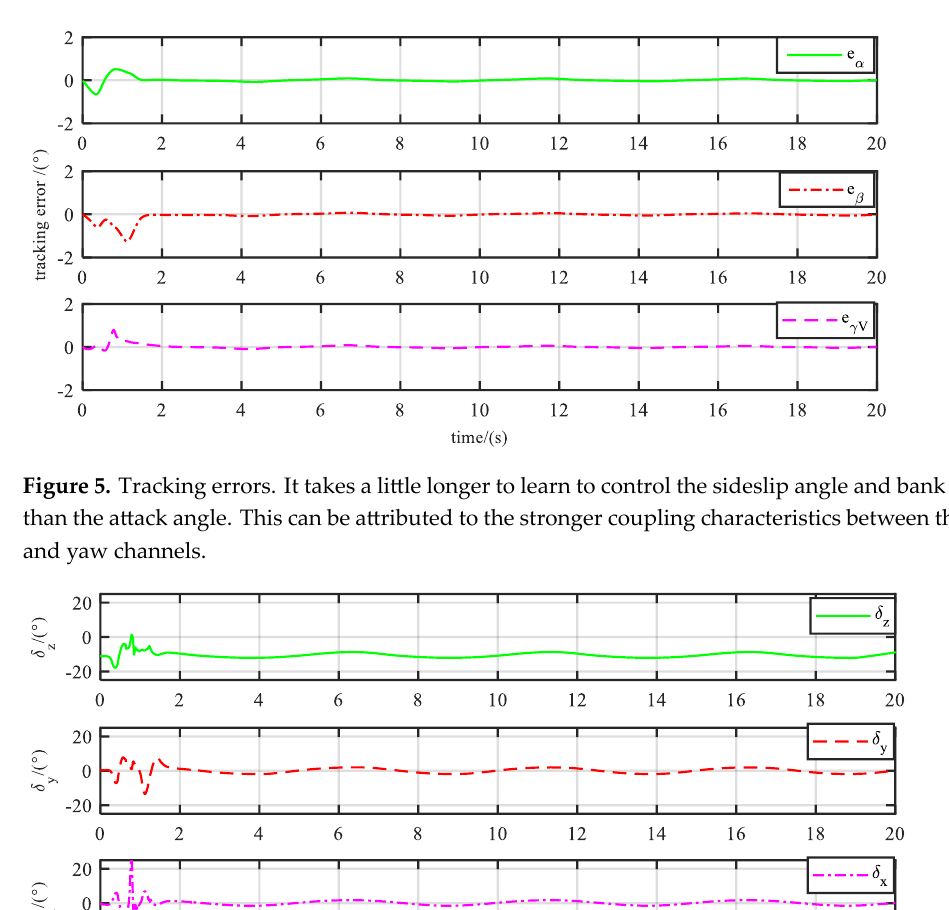
Figure 4. Tracking performance. The attack angle, sideslip angle, and bank angle response ( left ), and angular rates responses ( right ). It can be seen that the angles can follow the reference signals in about 2 seconds. There are certain oscillations in each channel to fully excite the identification and optimize the learning process.